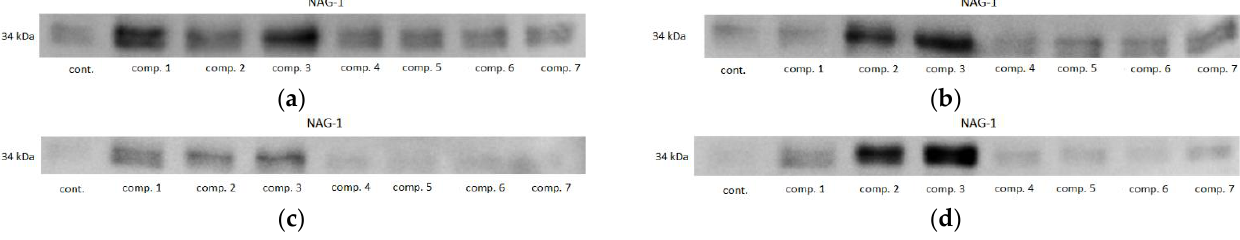
Figure 12. Representative immunoblots of oxicam’s effect on NAG1 protein expression in: ( a ) HCT 116 cells treated with 50 µM oxicams; ( b ) HCT 116 cells treated with 200 µM oxicams; ( c ) HT-29 cells treated with 50 µM oxicams; ( d ) HT-29 cells treated with 200 µM oxicams. Cont., control; comp., compound.